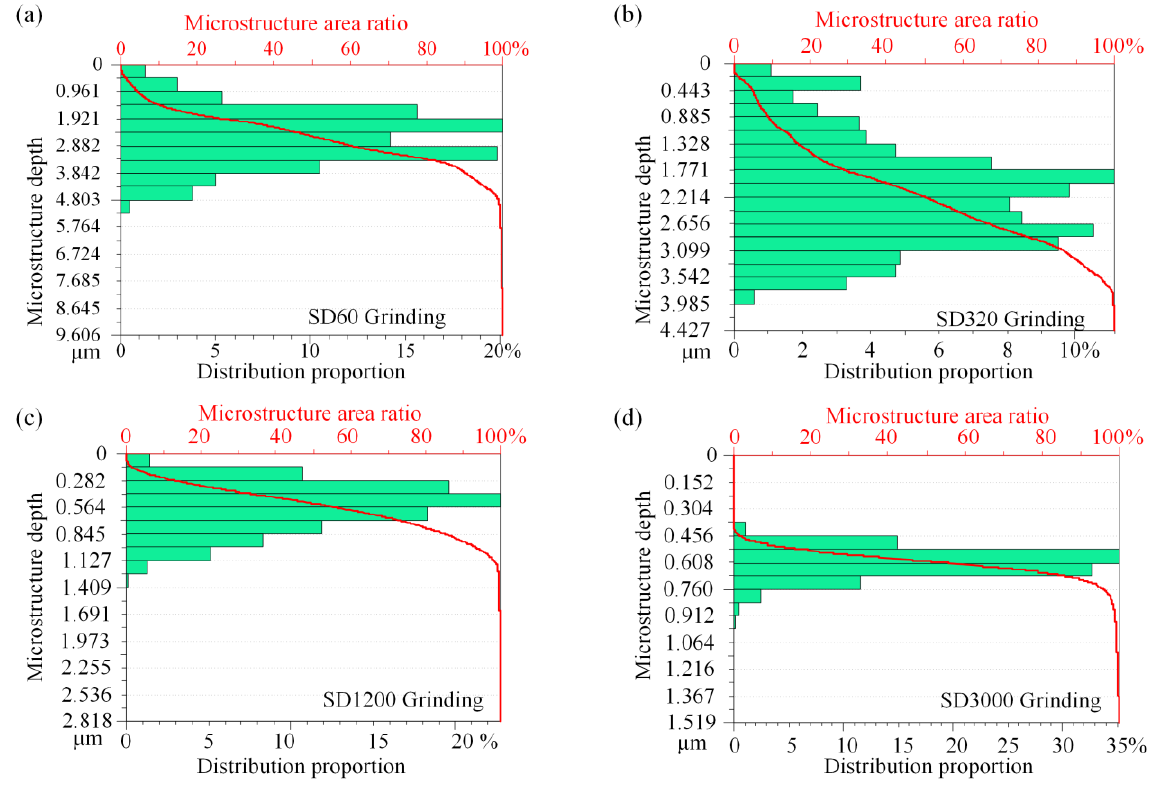
Figure 5. Characterization of BLHS surfaces by Abbott – Firestone curves. Surfaces micromachined by ( a ) SD60, ( b ) SD320, ( c ) SD 1200, and ( d ) SD 3000 diamond grinding wheels, respectively.